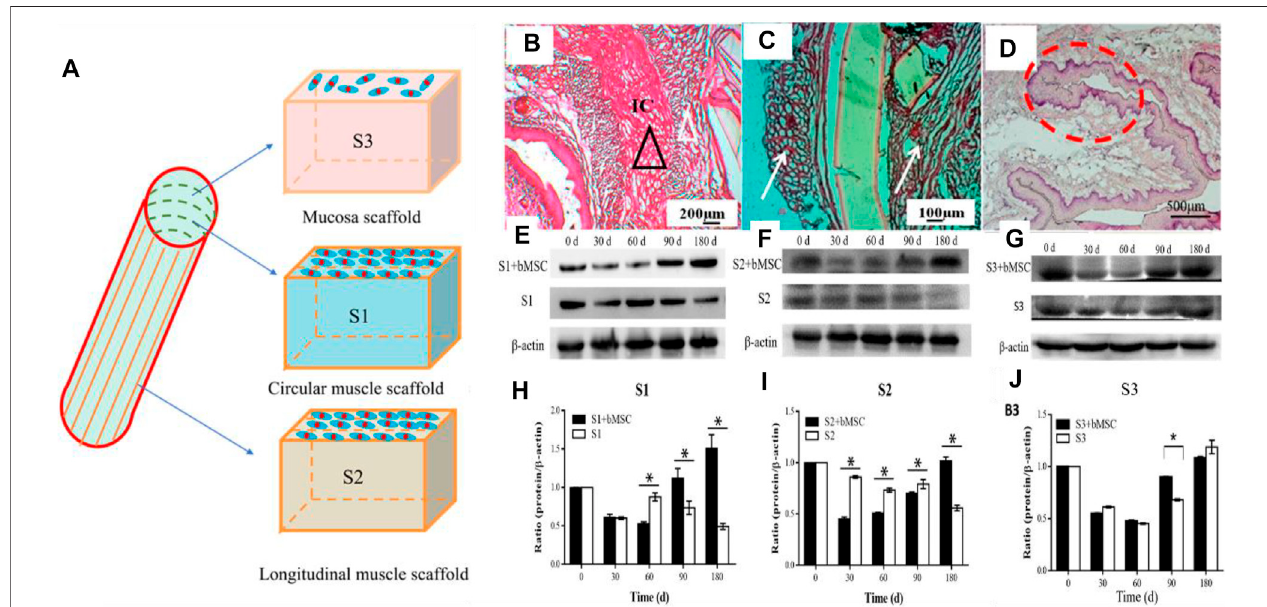
FIGURE6| Multi-layer esophagealscaffoldcombined withstemcells torepair esophageal defect inrabbits. (A) Schematic diagram ofthethree-layerscaffold; S1, S2, and S3, respectively, represent the inner ring muscle, outer longitudinal muscle, and mucosal layer of the esophagus. (B – D) H&E staining of rabbit esophagus sections at 180 days (E – G) Western blot evaluated the expression of α -SMA (S1, S2) and CK-14 (S3), respectively, in rabbit esophageal defect. (H – J) Quantitative calculation of (E – G) using ImageJ software ( n = 3). * p < 0.05 (Wang X. et al., 2020).